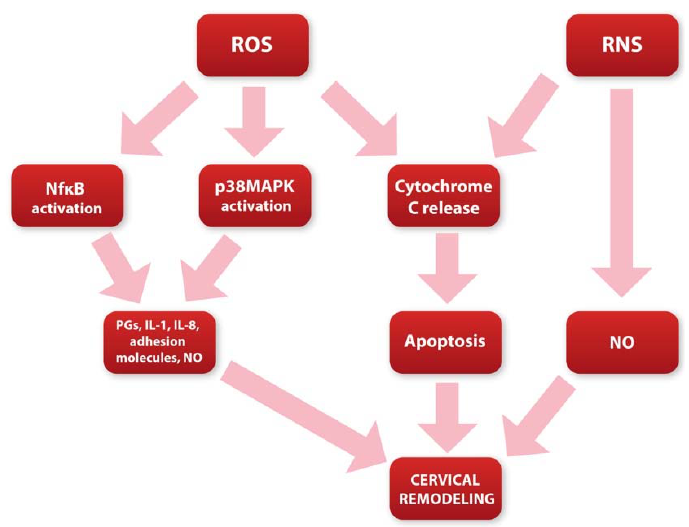
Figure 2. Diagram showing potential role of ROS and RNS in cervical ripening. Interleukin 1 (IL ‐ 1) is a powerful cervical ripening regulator. Vaginal application of suppositories with IL ‐ 1 leads to significant softening of the cervix [64]. IL ‐ 1 has the ability to downregulate PG dehydrogenase (PGDH) and upregulate cyclooxygenase ‐ 2 (COX ‐ 2)